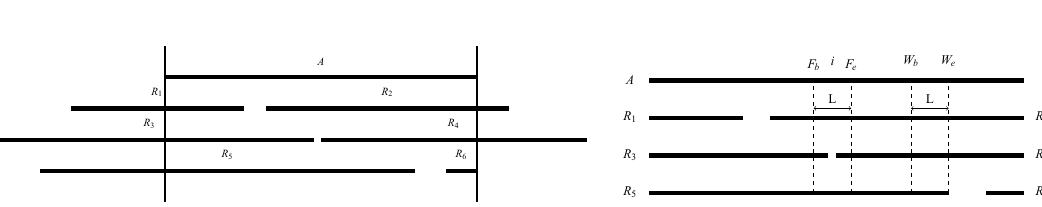
Figure 1. Overview of CONSENT’s workflow for long read error correction.